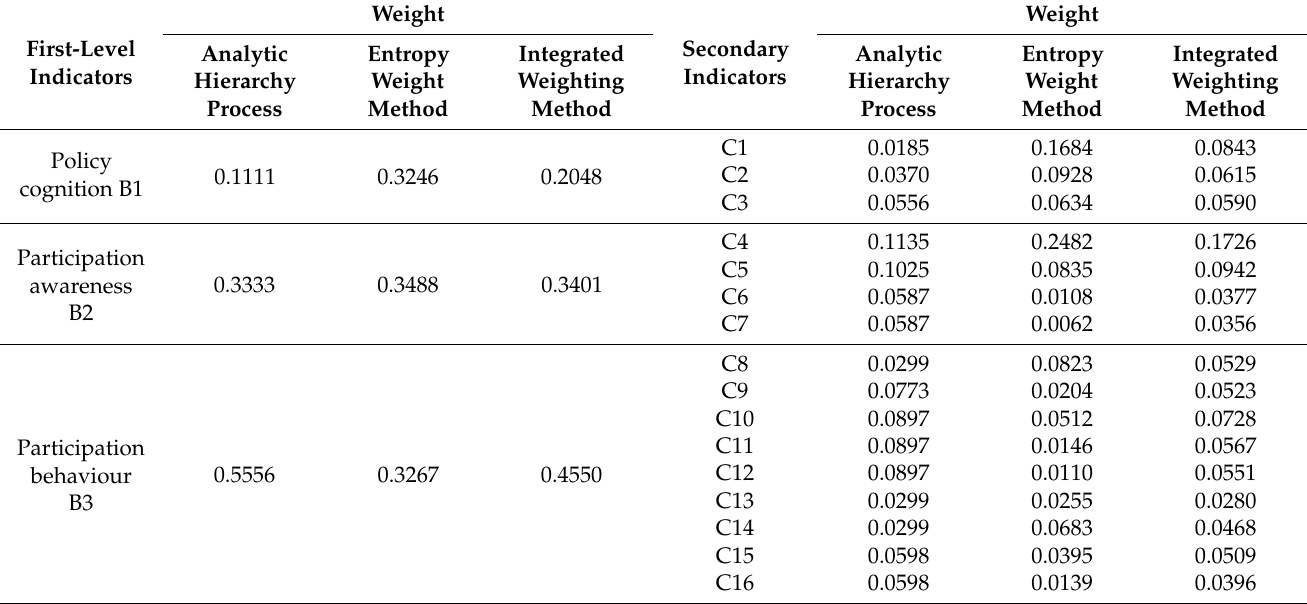
Table 5. Weights of the evaluation indicators of farmers’